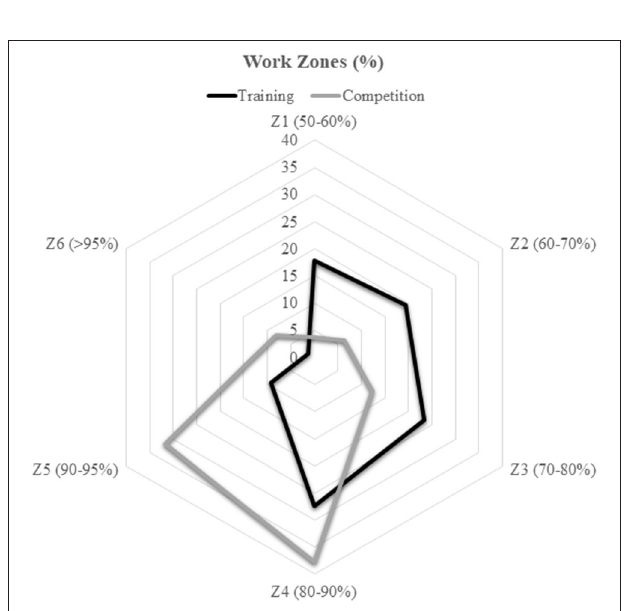
FIGURE 3 | Work zones by game